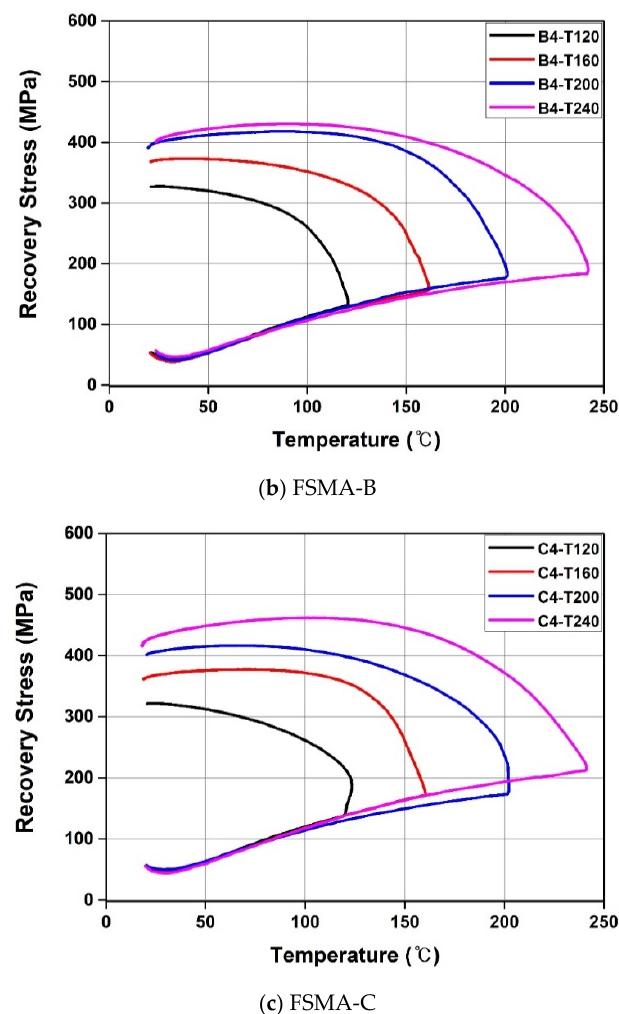
Figure 8. Comparison of temperature-recovery stress curves by heating temperature under rigid restraint.